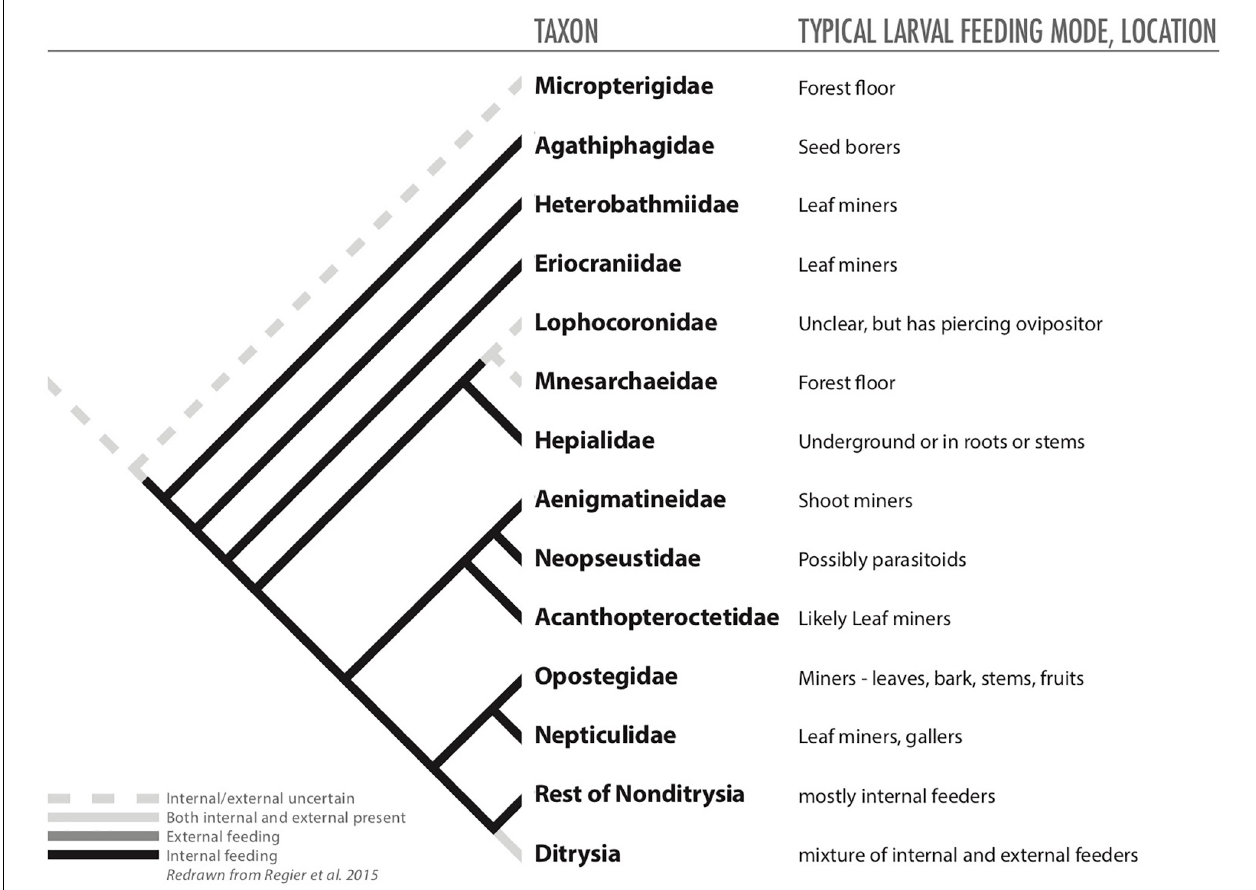
FIGURE 4 | Phylogeny of basal Lepidoptera (from Regier et al., 2015) redrawn to illustrate hypothesized distributions of internal and external feeding among